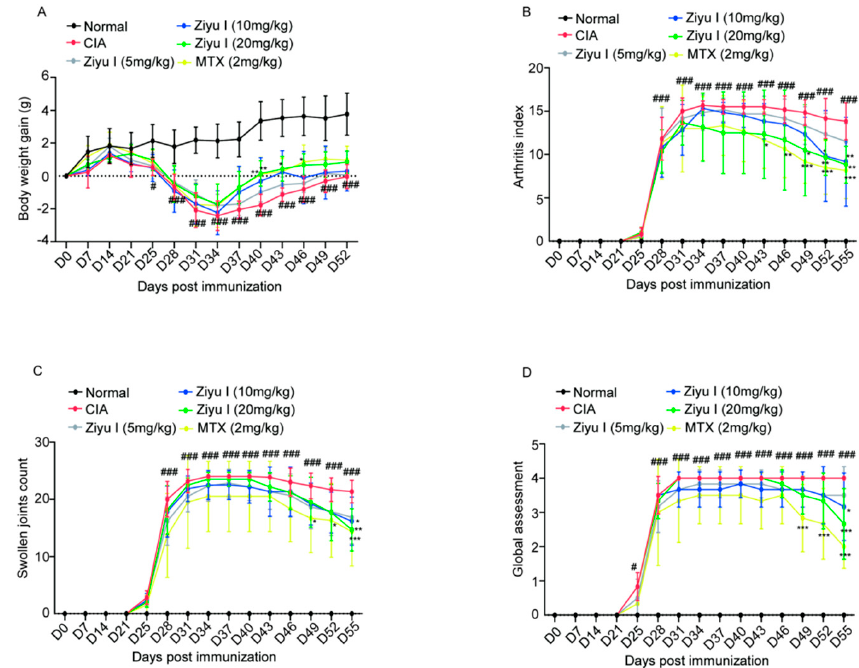
Figure 1. Ziyu I treatment effectively improves the manifestations of mice with CIA. ( A ). Body weight gain (g) ( B ). Arthritis index ( C ). Swollen joint count ( D ). Global scoring. The data were expressed as mean ± SD, n = 5~6. # p < 0.05, ### p < 0.001 vs. Normal. * p < 0.05, ** p < 0.01, *** p < 0.001 vs. CIA.